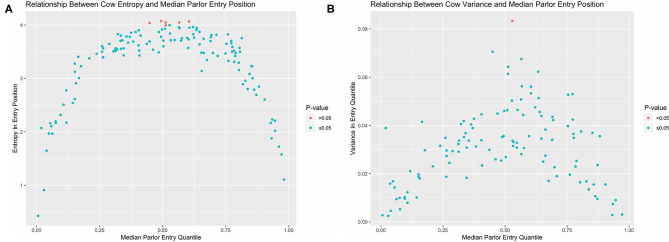
Observed entropy (A) and variance (B) values for each cow plotted against their corresponding median entry position. Cows with the greatest consistency in parlor entry position are found at the front and end of the queue. With both estimators, nearly all cows in the herd demonstrate less stochasticity in parlor entry position than completely random queue formation as determined by permutation test.